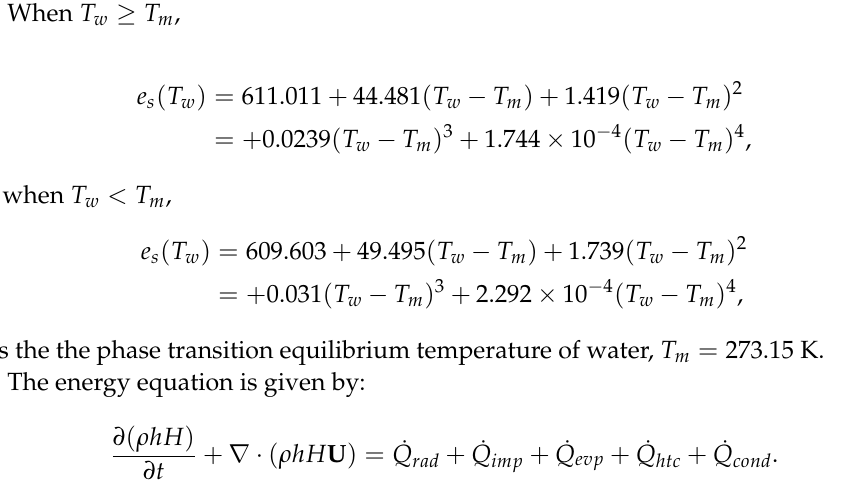
Figure 2. Diagram of mass and energy transfer in the control